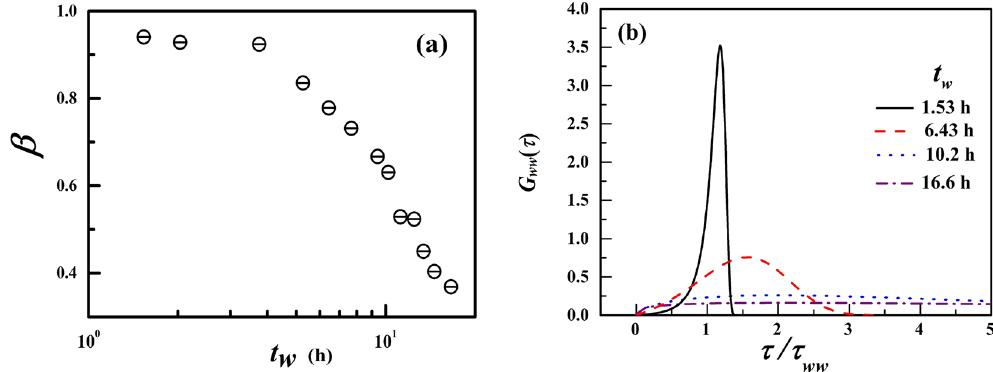
Figure 2. ( a ) The stretching exponent β vs. t w and ( b ) the distribution of relaxation time scales G ww ( τ ) plotted at various t w for the Laponite-PS system C L = 3.0 wt.% of Fig.